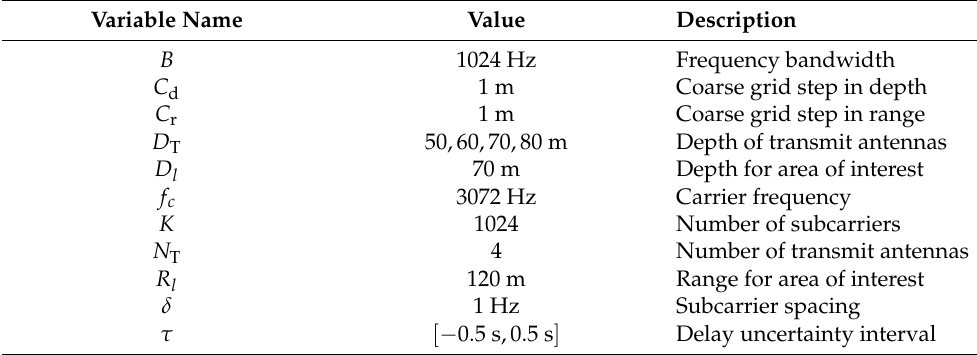
Table 1. Simulation parameters used in an example of receiver